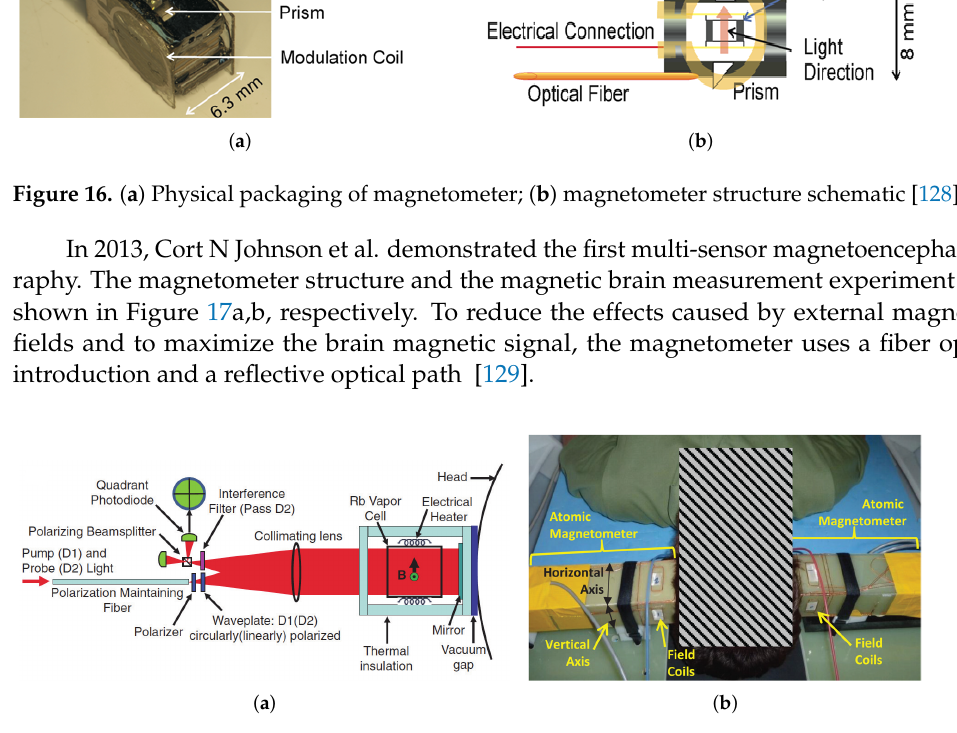
Figure 17. ( a ) Physical packaging of magnetometer; ( b ) experimental map of the brain magnetome- ter